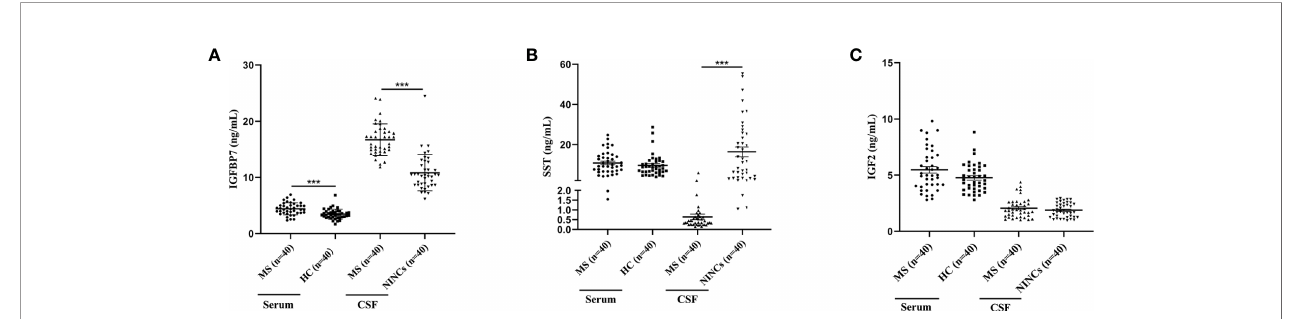
FIGURE 4 | Dot Plots showing levels of IGFBP7, SST and IGF2 in serum and CSF samples of MS and controls. (A) IGFBP7 measurements in the serum and CSF of patients with MS and controls. (B) SST measurements in the serum and CSF of patients with MS and controls. (C) IGF2 measurements in the serum and CSF of patients with MS and controls. For simplicity, only signi fi cant differences are shown. Statistical signi fi cance was de fi ned as ***P < 0.001.